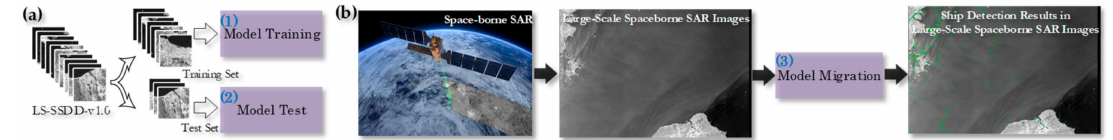
Figure 1. Deep learning-based synthetic aperture radar (SAR) ship detection. ( a ) Model establishment; ( b ) model application. (1) Model training on the training set; (2) model test on the test set; (3) model